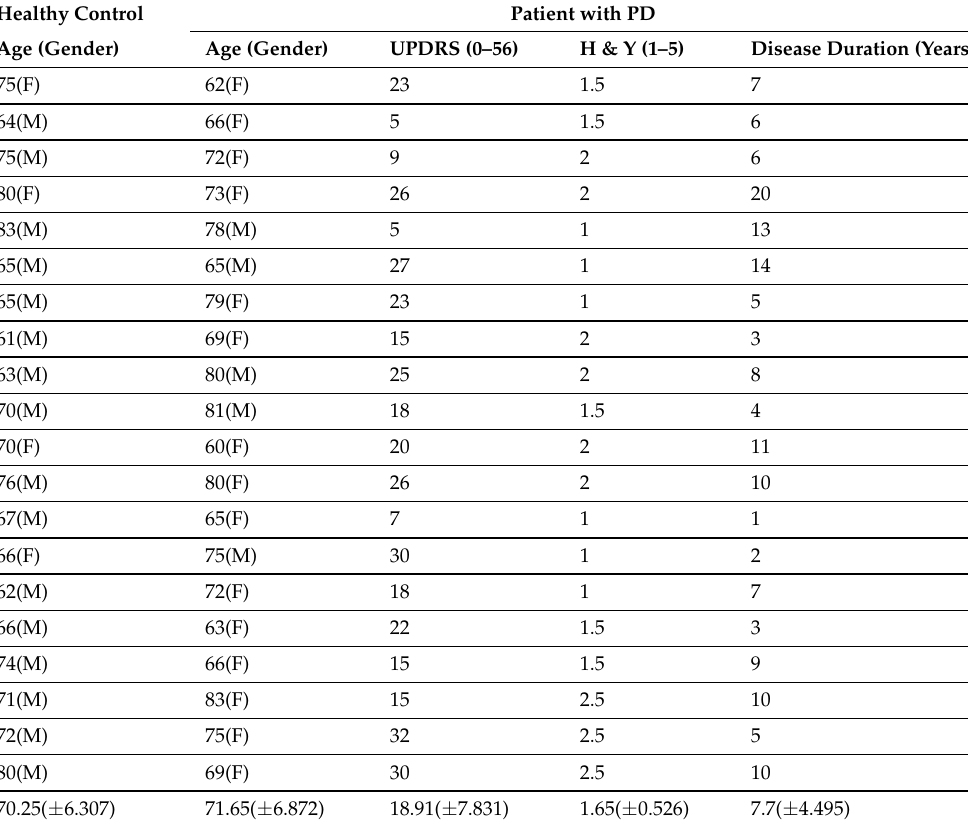
Table 4. Demographic and clinical details of healthy control and patient with Parkinson disease. Healthy Control Patient with